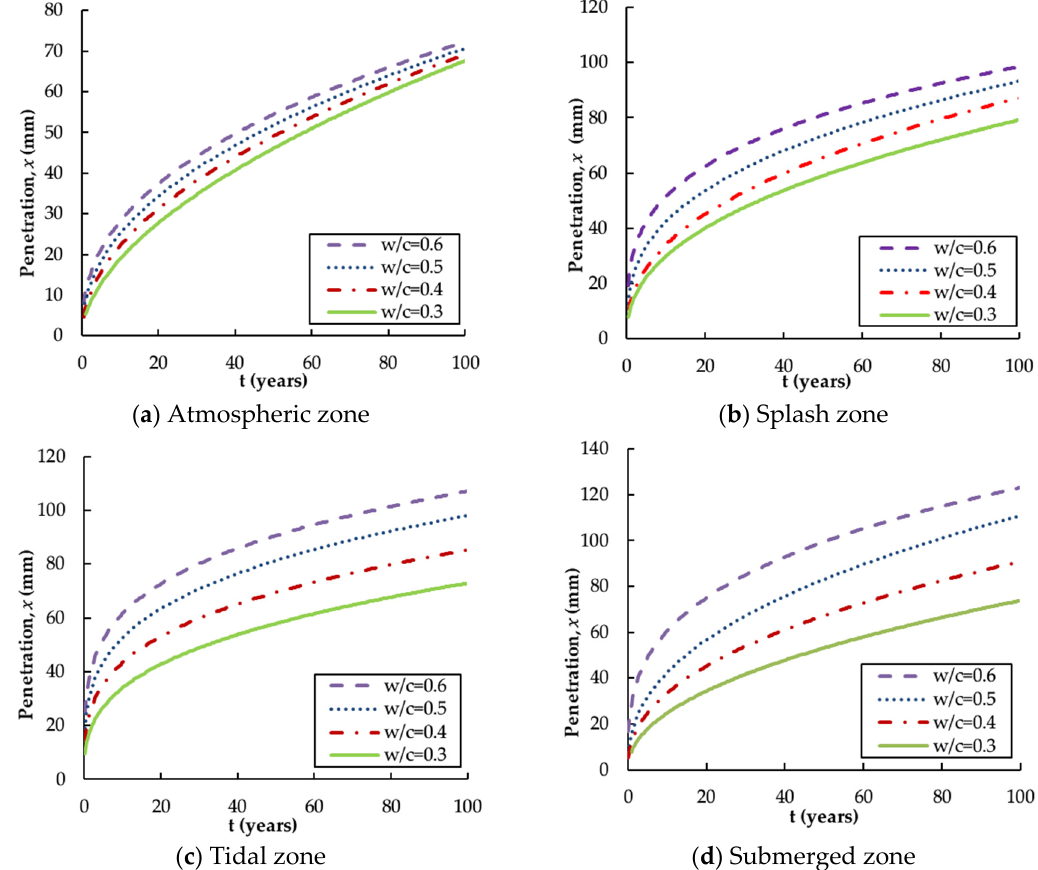
Figure 4. Influence of 𝑤/𝑐 ratio on penetration depth versus time in different zones: ( a ) Atmospheric zone; ( b ) Splash zone; ( c ) Tidal zone; ( d ) Submerged zone.